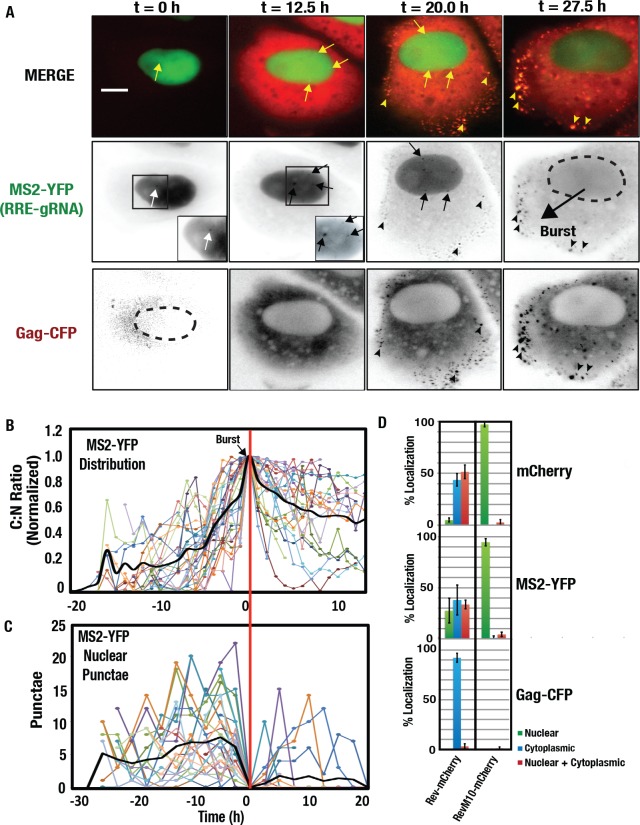
Rev- and CRM1-dependent “burst” HIV-1 gRNA nuclear export.
(A) Select images from time lapse imaging showing MS2-YFP-tagged RRE-gRNAs and Gag-CFP subcellular distribution over 27.5 hours. “MERGE” shows Gag-CFP (pseudocolored red) and MS2-YFP tagged RRE-gRNA (green) with yellow arrowheads highlighting co-localization (yellow) of Gag and gRNA at the plasma membrane at later time points (20 and 27.5 hrs). The dotted line at the 27.5 hour panel for the MS2-YFP (RRE-gRNA) indicates the intact nuclear membrane after MS2-YFP has been evacuated from the nucleus. Size bar represents 20 um. (B) Burst export events. MS2-YFP tagged gRNA signals were measured in the cytoplasm and nucleus for 30 cells, normalized for peak cytoplasmic to nuclear (C:N) ratios of mean fluorescence intensity, and then aligned to this peak as t = 0. (C) Number of RRE-gRNA transcripts detected in the nuclear compartment of Hela.MS2-YFP cells before and after burst export for the cells measured for (B). (D) Quantification of subcellular distribution phenotypes as described for Fig 1E for RRE-gRNA transcripts expressed either with wild-type Rev-mCherry or a mutant Rev fusion protein (RevM10-mCherry) that cannot bind to CRM1. Error bars represent the standard deviation of the mean for 3 independent transfections (n ≈ 300 cells for each condition).